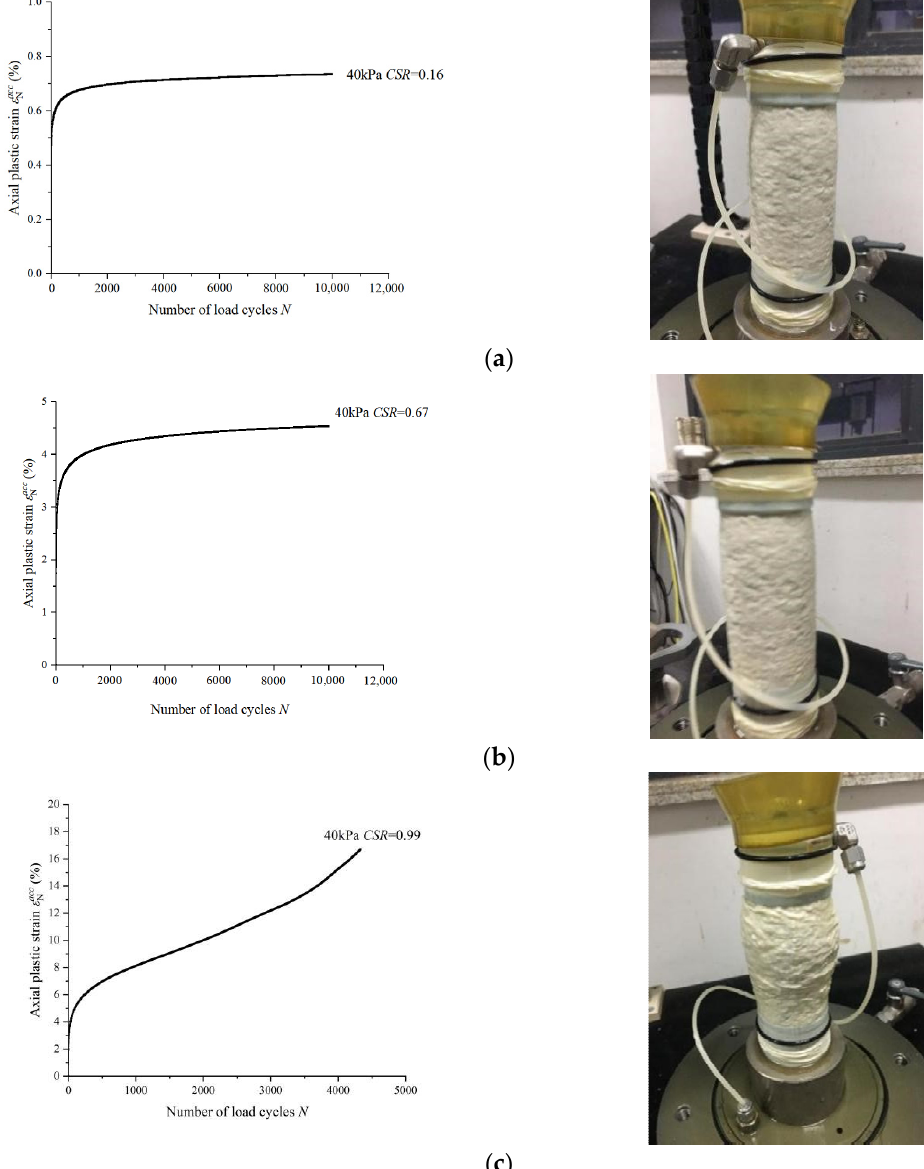
Figure 14. Response statuses of calcareous sand: ( a ) Plastic shakedown status; ( b ) Plastic creep sta- tus; ( c ) Incremental plastic failure status. ( c ) Incremental plastic failure